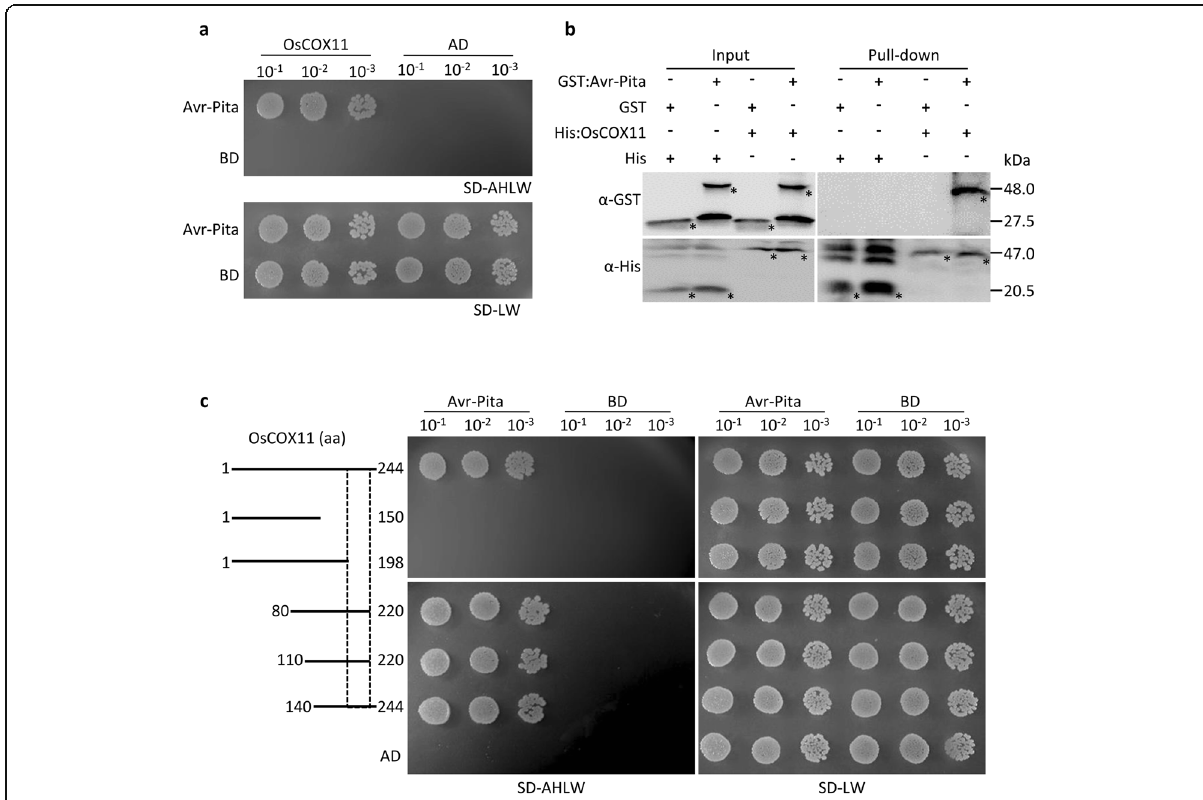
Fig. 2 Avr-Pita interacts with OsCOX11. a Analysis of protein – protein interactions between BD:Avr-Pita (mature protease) and AD:OsCOX11 via yeast-two-hybrid (Y2H) assay. Yeast cells harboring the indicated bait and prey plasmids were diluted 10×, 100×, or 1000× and spotted onto selective media SD-LW and SD-AHLW. b In vitro pull-down assays were conducted with fusion proteins (GST:Avr-Pita and His:OsCOX11) using His- Ni beads and detected by immunoblot analysis with anti-GST and anti-His antibodies. Asterisks indicate the target protein. (c) Deletion assays of OsCOX11 to test interactions with Avr-Pita. A series of truncated OsCOX11 proteins were tested for interaction with Avr-Pita via